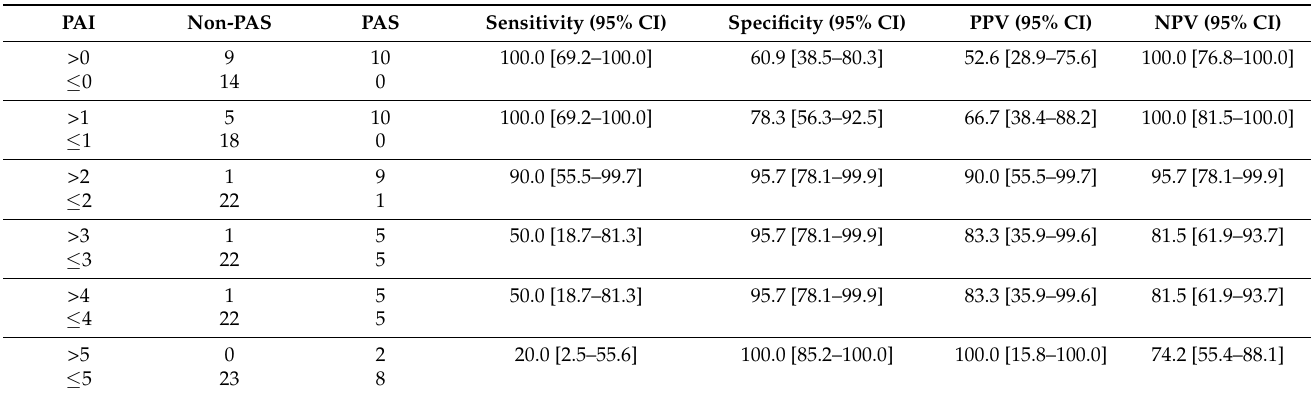
Table 3. Sensitivity, specificity, and positive and negative predictive values corresponding to each PAI